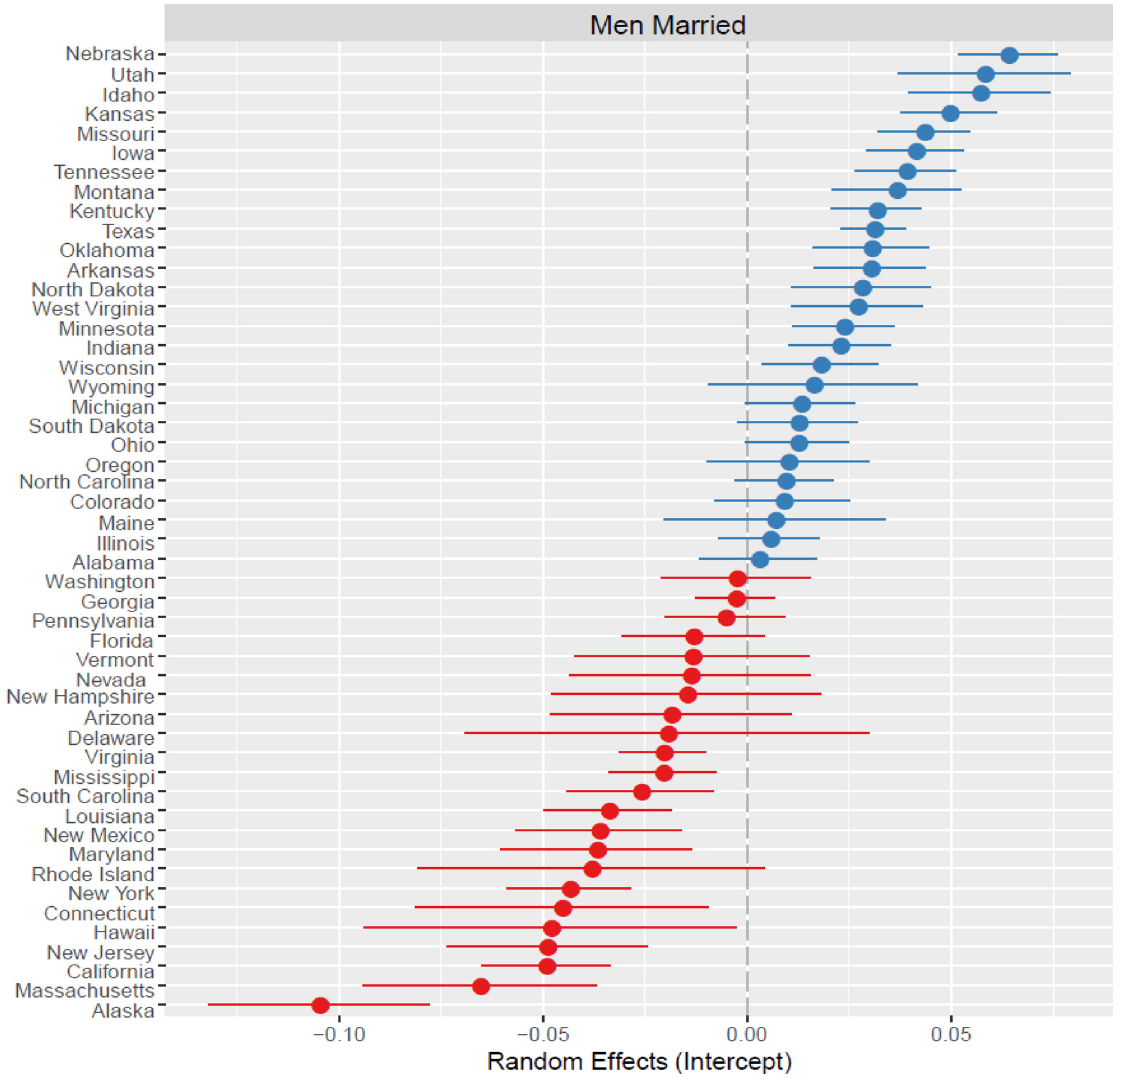
Fig 2. Plot of the random effects for the outcome variable Men Married. State-level deviations are shown relative to the mean (0.00; gray dashed line) with 95% confidence intervals around the intercept (closed circle). Blue circles represent intercepts higher than the mean and red circles lower than the